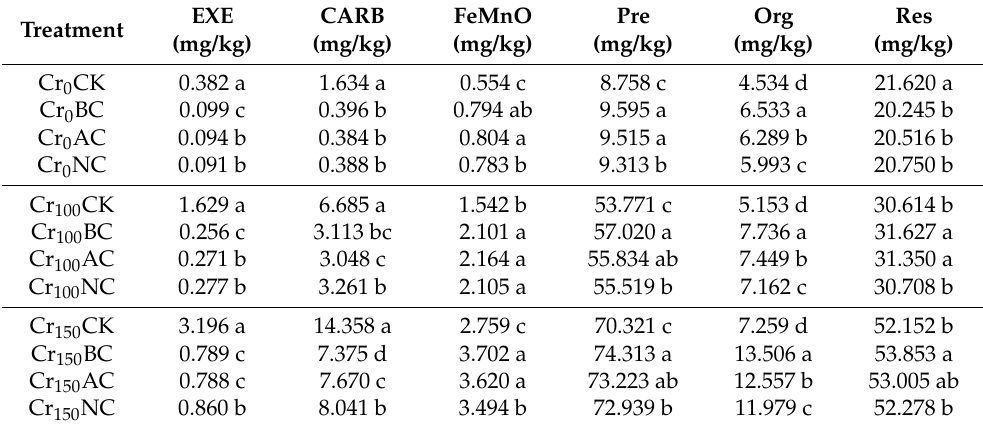
Table 2. Effect of BC, AC, and NC application on the speciation of Cr in soil.